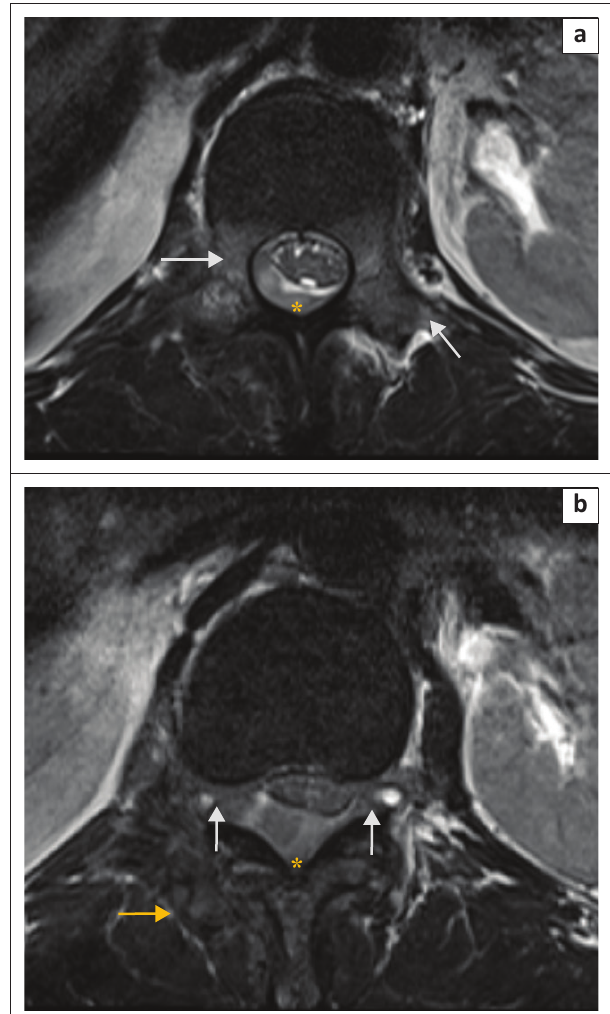
FIGURE 2: Serial axial T2W images (a and b) at the level of the L1 vertebra show hyperintense signal in both pedicles and transverse processes (arrows, a) indicating involvement. The soft tissue mass (yellow asterisk, a and b) is causing anterior displacement of the conus medullaris with marked compression (b). There is extension through and widening of bilateral neural foramina (arrows, b). The paraspinal muscles on the right side appear heterogeneously hyperintense suggestive of infiltration (yellow arrow,